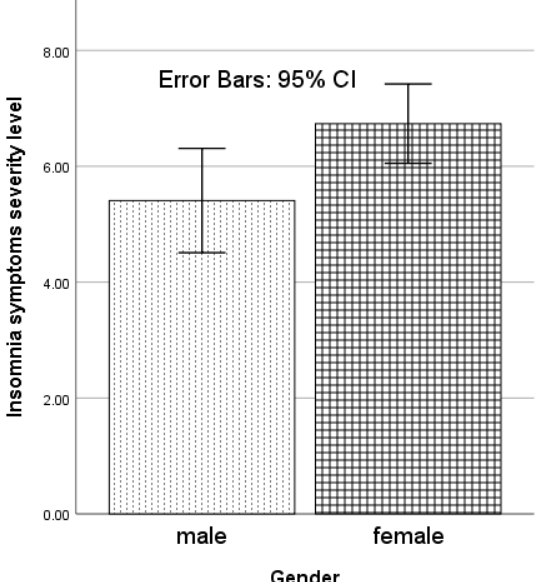
Figure 1. Gender-related variation in insomnia symptoms severity level (Athens Insomnia Scale